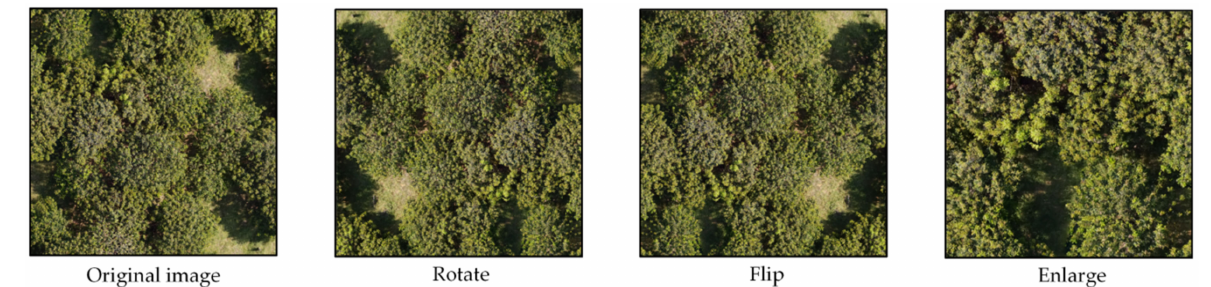
Figure 4. Geometric transformations.